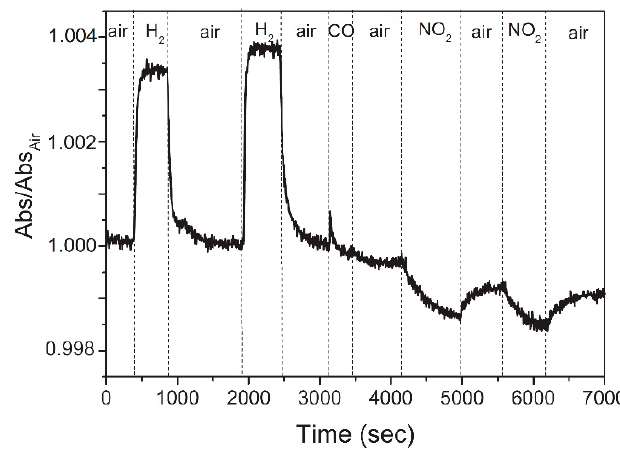
Figure 5. Absorbance change of rGO/Au NPs sample exposed to 10,000 ppm H 2 , 10,000 ppm CO and 1 ppm NO 2 . The incident wavelength is 528 nm (adapted from [46], Copyright 2013, with permission from Elsevier, Amsterdam, The Netherlands).